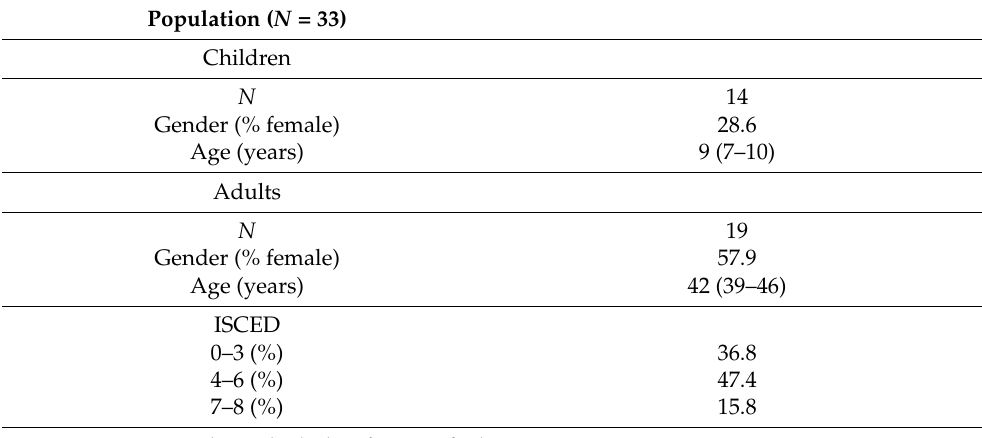
Table 2. Descriptive characteristics of the study participants.